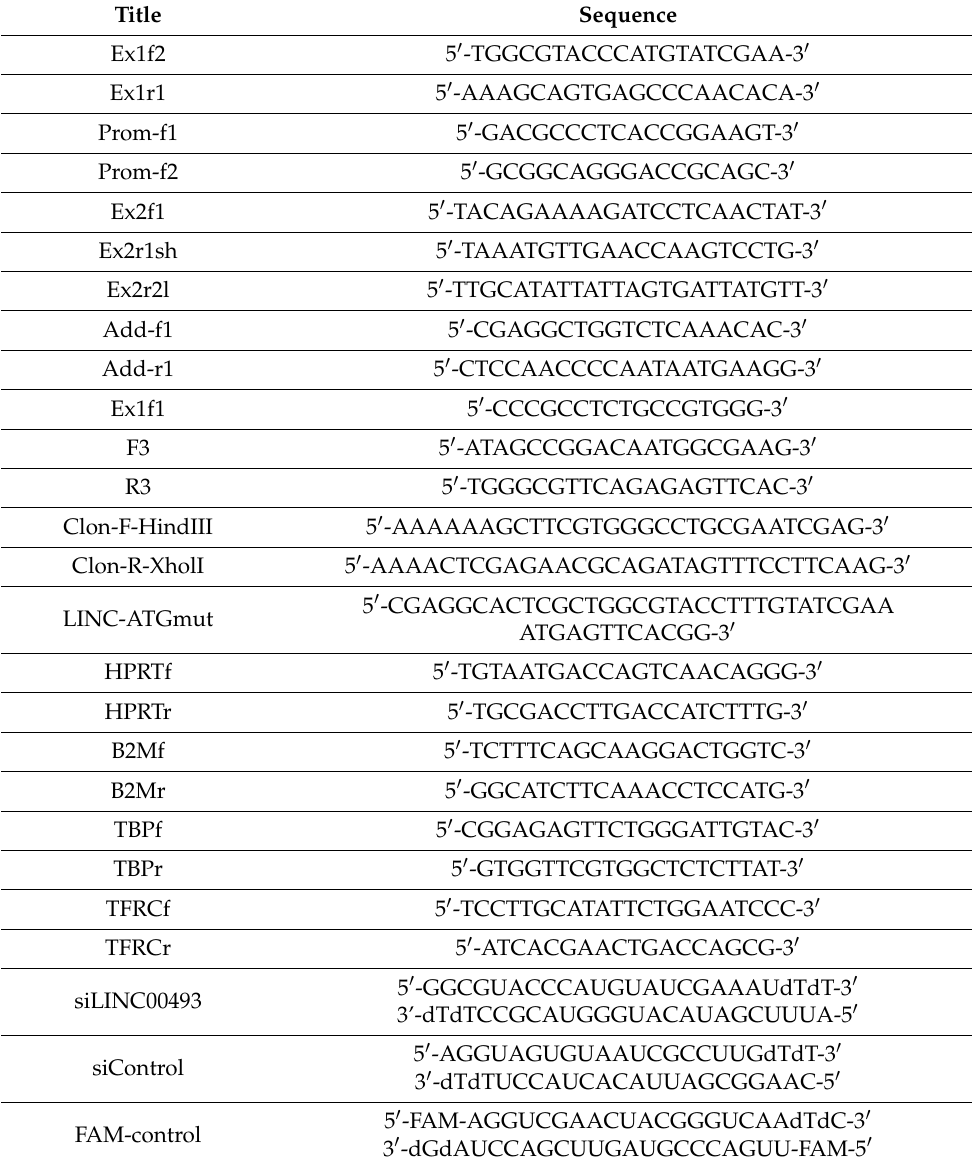
Table 1. Primer sequences used for amplification of different LINC00493 loci and housekeeping genes; siRNA sequences used for